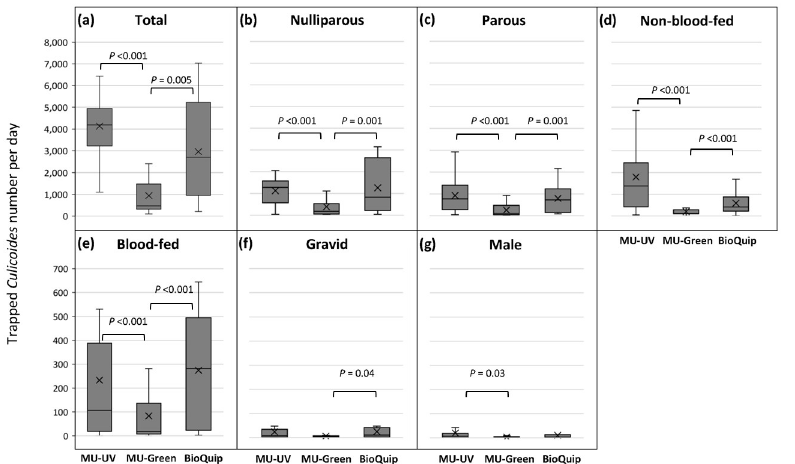
Fig 2. Box-and-whisker plots of daily number of Culicoides collected with three different LED light traps over 12 nights between 26 th July and 7 th August 2020 in Sai Yok District, Kanchanaburi Province, Thailand. The total count (a) and each physiological stage count (b–g) are shown. The cross marks in the middle of bars indicate the mean of the collection number per